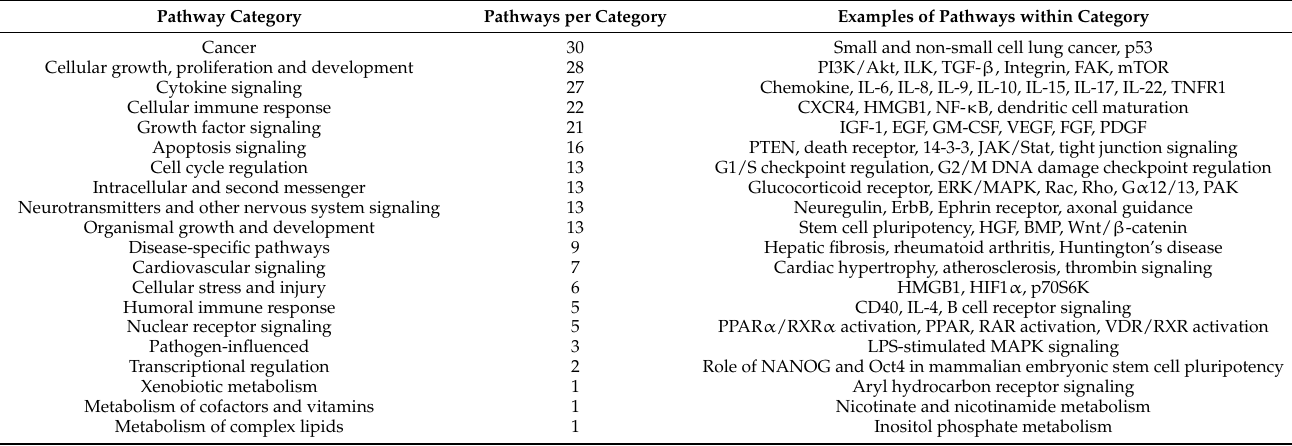
Table 3. Categories of pathways with significant ATII miR–target